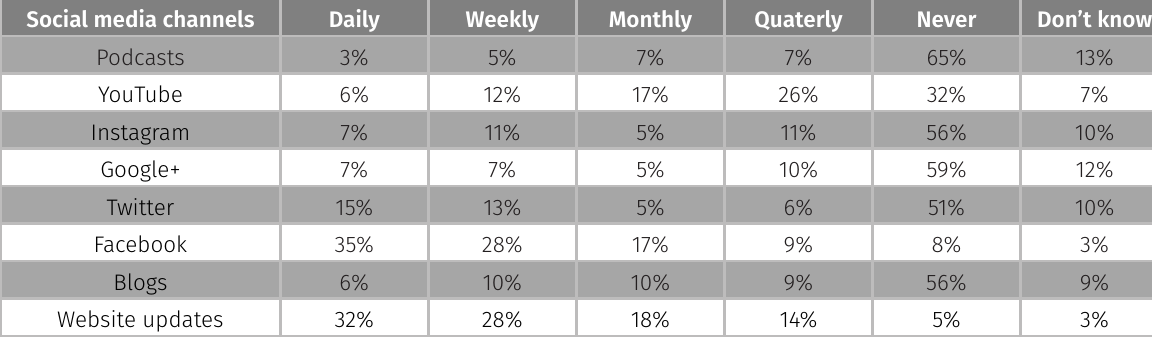
Table V. Frequency of communication through social media